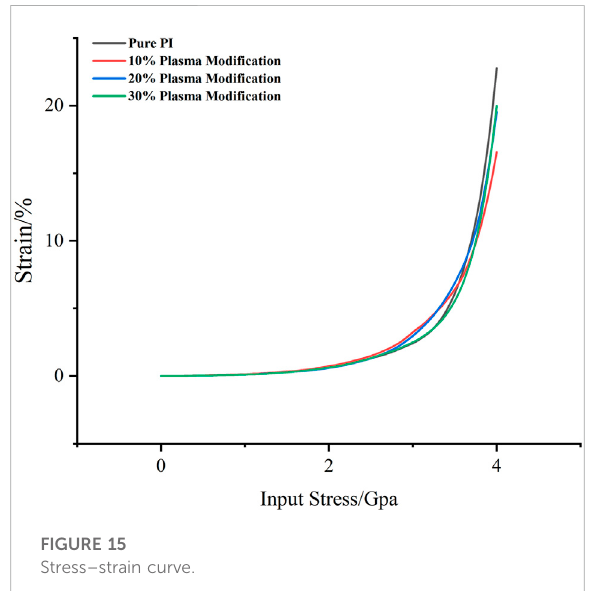
FIGURE 15 Stress – strain